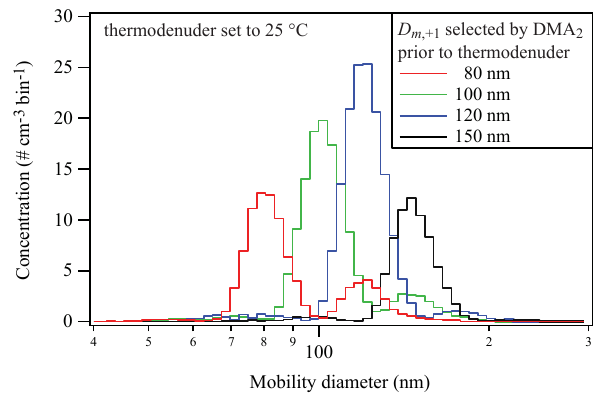
Fig. 2. Number-diameter distributions (#cm − 3 bin − 1 ) measured by SMPS 2 for different settings of DMA 2 in Experiment 2 for a ther- modenuder setting of 25 ◦ C. Shoulders on the distributions at mobil- ity diameters greater than the selected D m , + 1 are apparent, arising from doubly charged particles that pass DMA 2 and are measured by SMPS 2 after